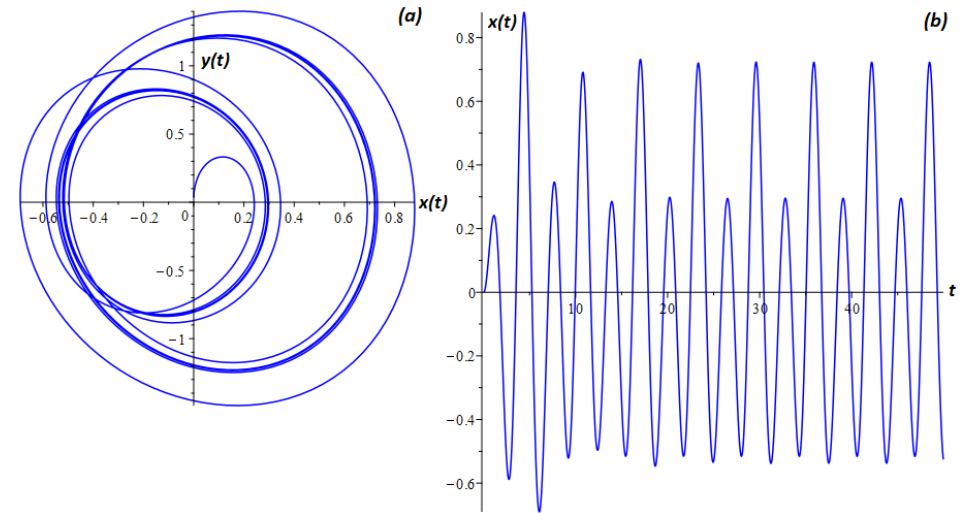
Figure 4. Phase trajectory ( a ) and oscillogram ( b ) for the Cauchy problem (1) under the conditions of Theorems 2 and 3 at N = 1500.